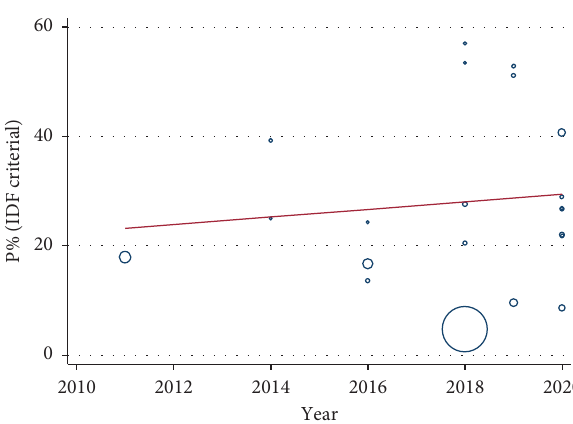
Figure 4: Meta-regression analysis based on published year using IDF criteria.